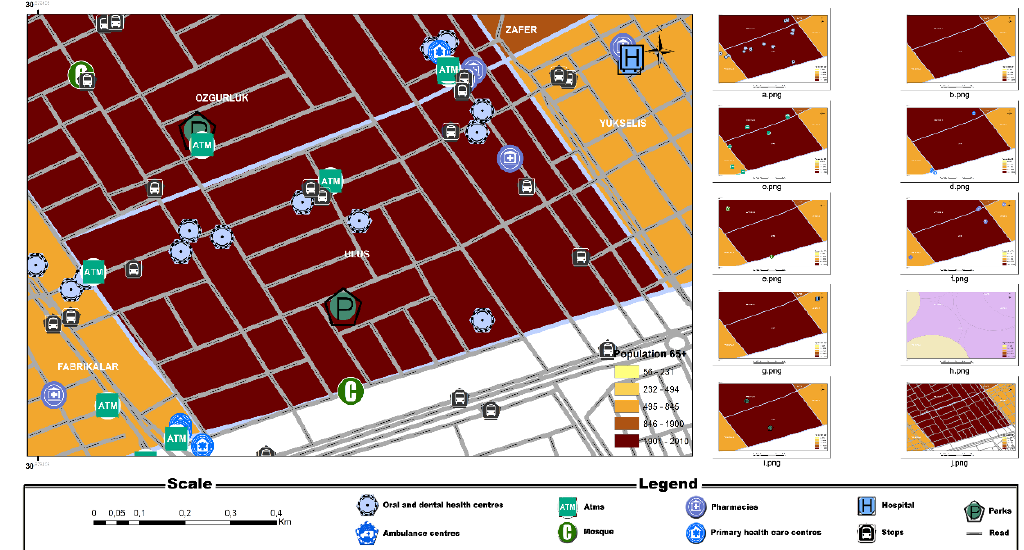
Figure 5. Location and density map of selected criteria in Ulus Neighbourhood.